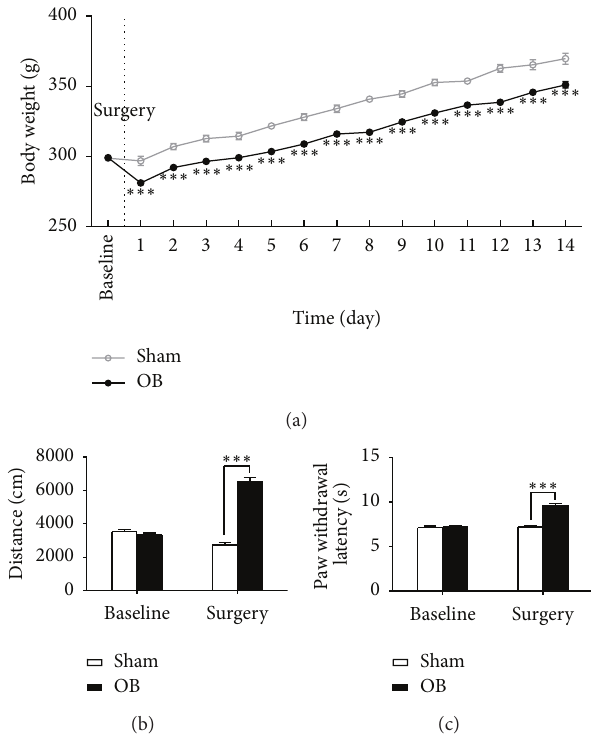
Figure 2: Behavioral outcome of the OB model for depression and depression-induced hypoalgesia. (a) Body weights. Significant decrease was observed in body weights in the OB group in compar- ison to the control group over the 14-day postoperation period ( 𝑛 = 33 – 48 ). (b) Open-field test. Significant higher level of locomotor activitywasfoundintheOBratsthaninthecontrolrats( 𝑛 = 33 – 48 ). (c) Thermal pain threshold test. The paw withdrawal latency to noxious radiant heat stimuli was significantly prolonged in the OB rats ( 𝑛 = 33 – 48 ). Data are presented as mean ± SEM. ∗∗∗ 𝑃 < 0.001